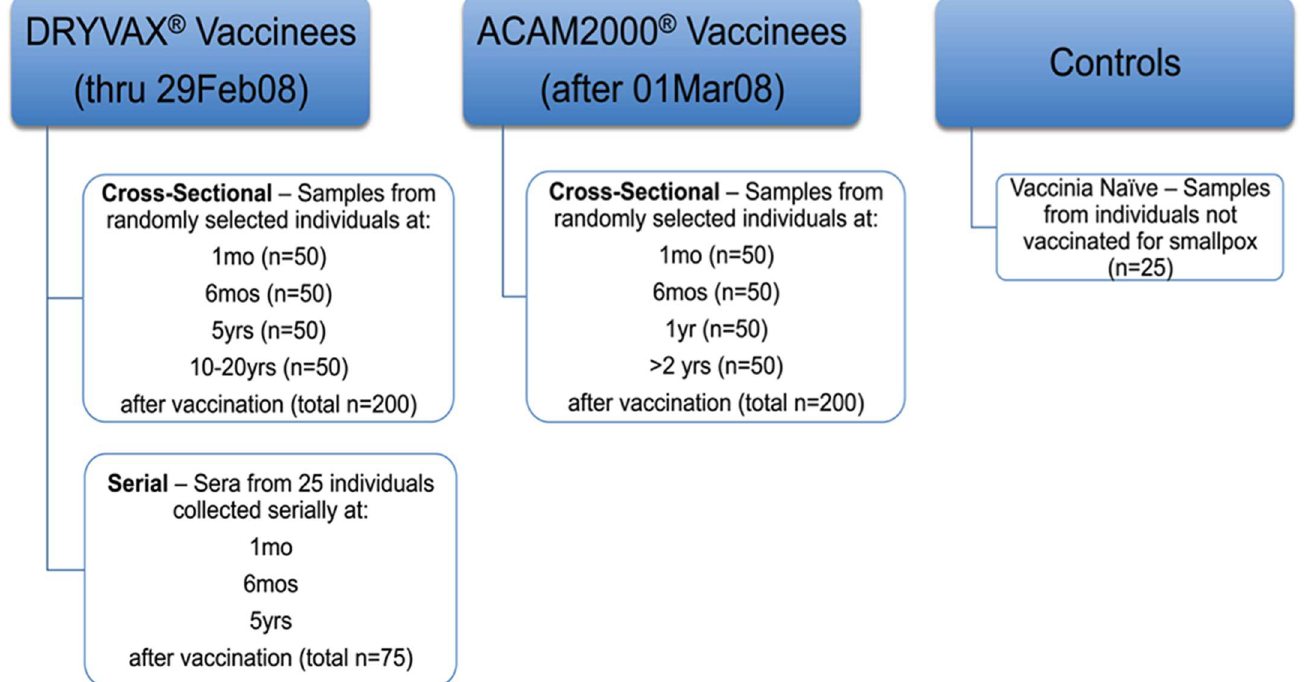
Fig 1. Study design. Sera from individuals were randomly selectedby DoDSR staff based on the followinginclusioncriteria: the sample must be banked sera stored in the DoDSR, with availablespecimensat the requisitetime points and with full documentation of smallpoximmunizationon record for the donor. Sampleswere excludedif the smallpoxvaccination status was unknown,the sample was positive for HIV infection, or there was inadequatesera volume.